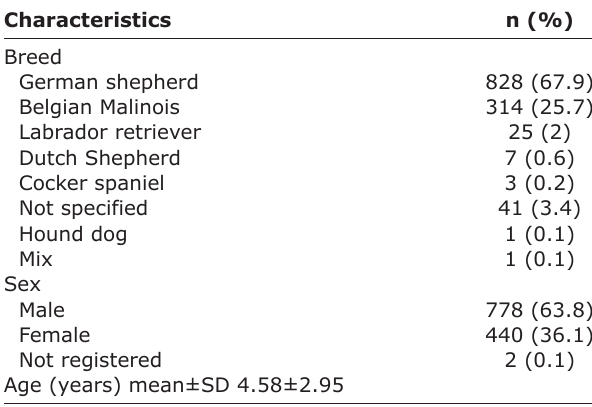
Table-1: Main characteristics of police dogs referred to Baghdad veterinary hospital in